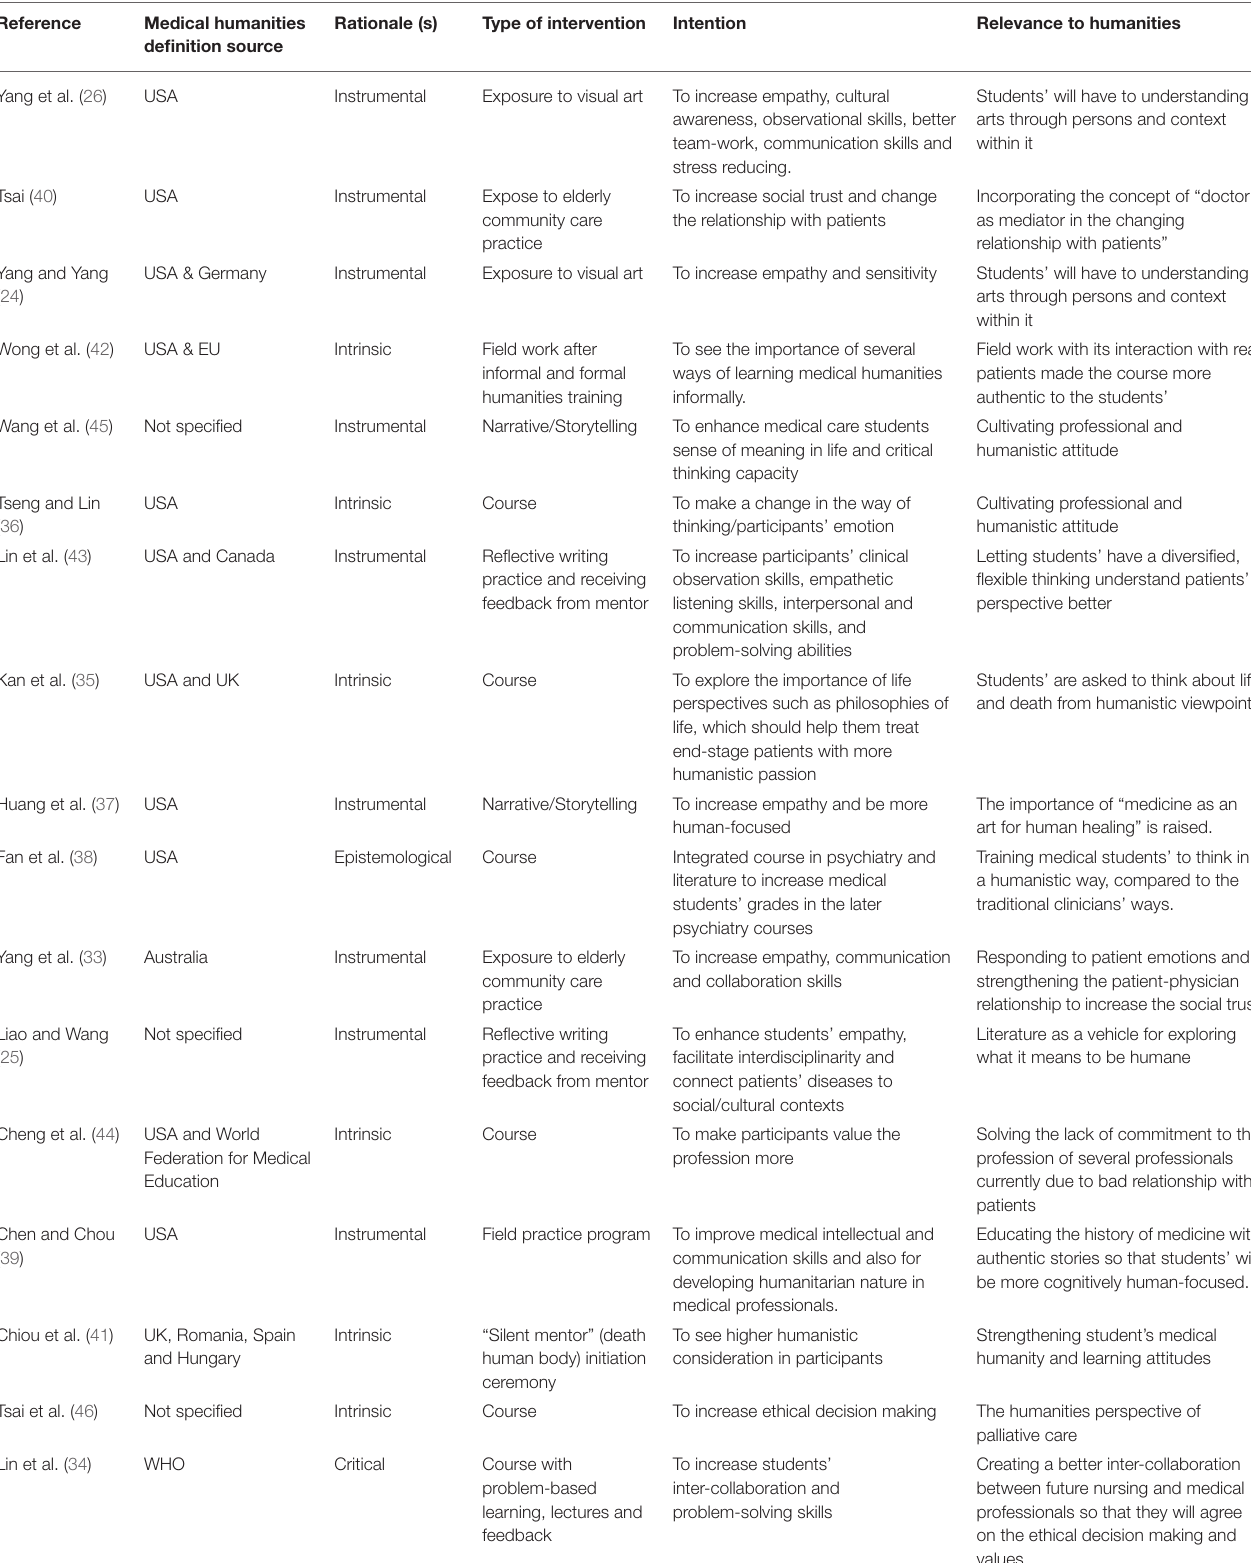
TABLE 1 | Extraction of medical humanities sources of definitions, types of interventions, intentions and the relevance of the researches to Taiwan’s medical humanities education.